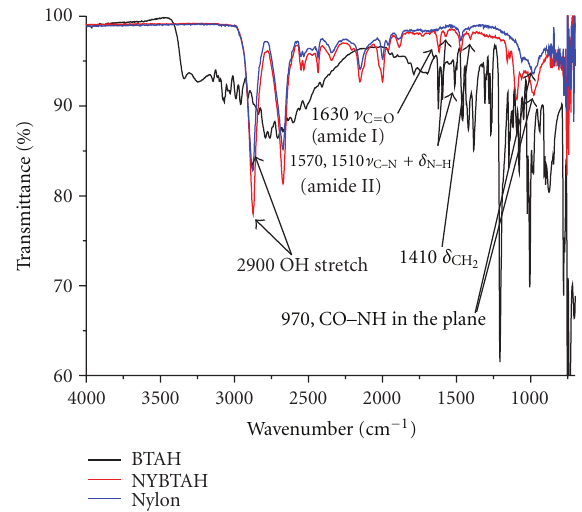
Figure 2: FT-IR of BTAH, nylon 6-6, and Ny-BTAH 20% coating fibers